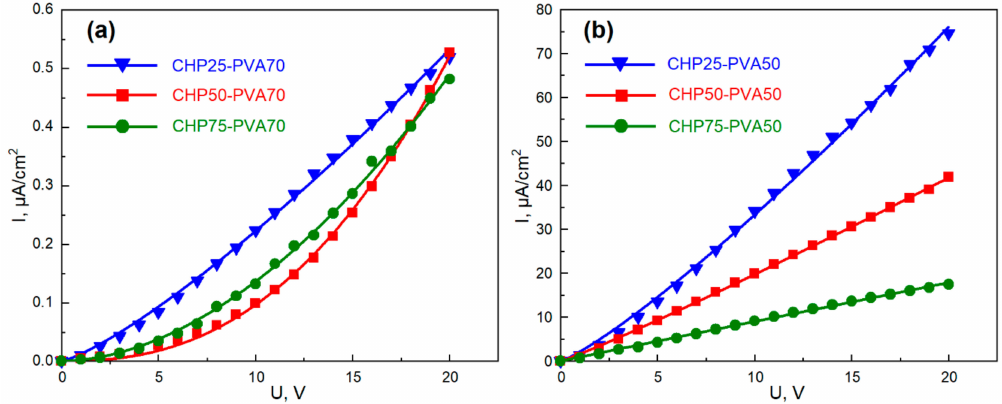
Figure 8. Current–voltage characteristics of the acid-doped PANI-based films: ( a ) with 70% w / w content of PVA; ( b ) with 50% w / w content of